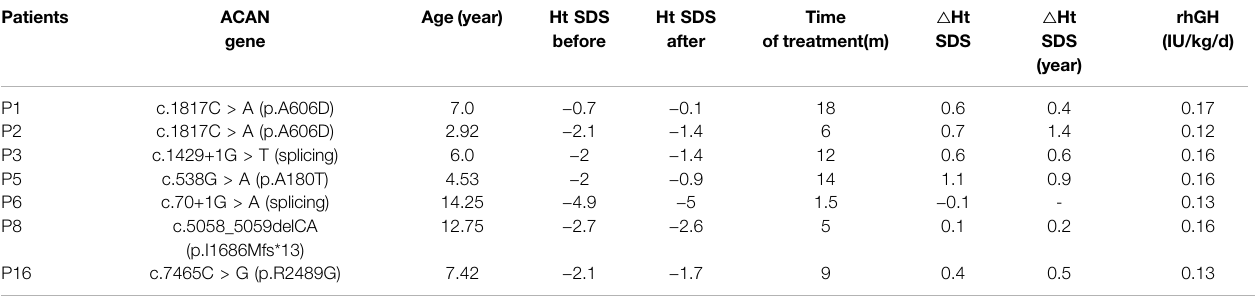
TABLE 3 | Responses to growth hormone